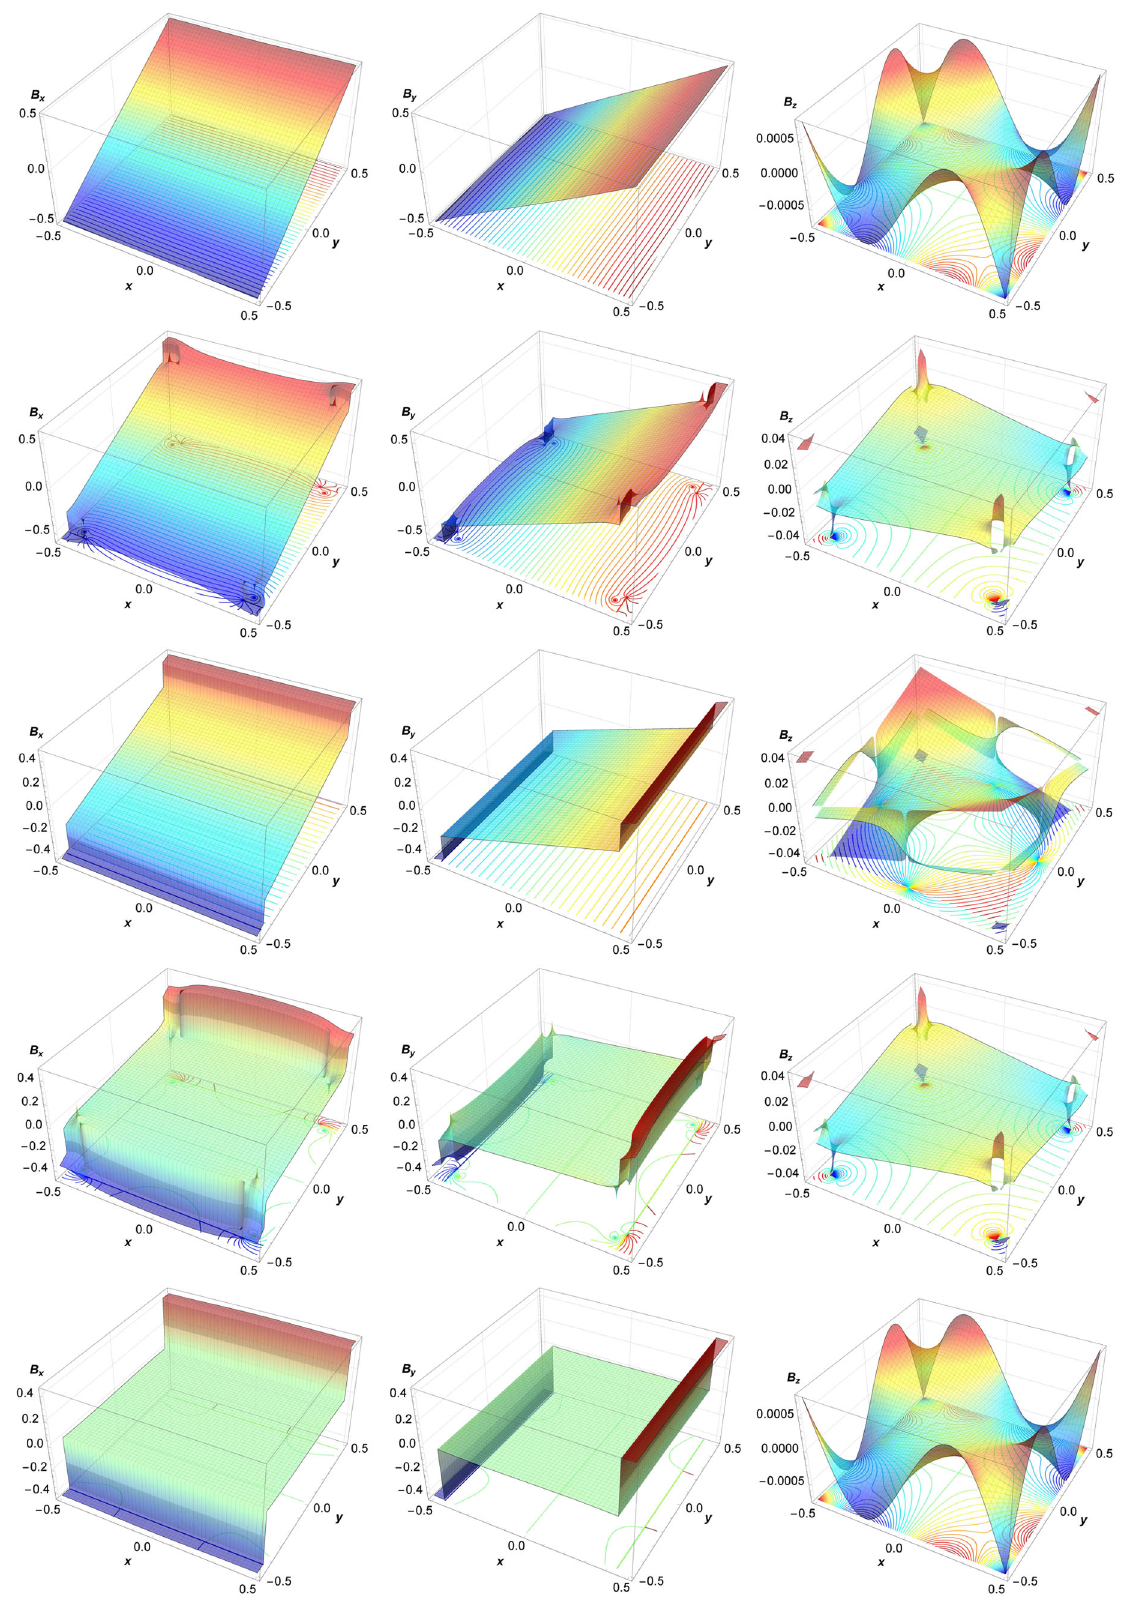
FIG. 5. Quadrupole fringe field components B and z ¼ 4 . 0